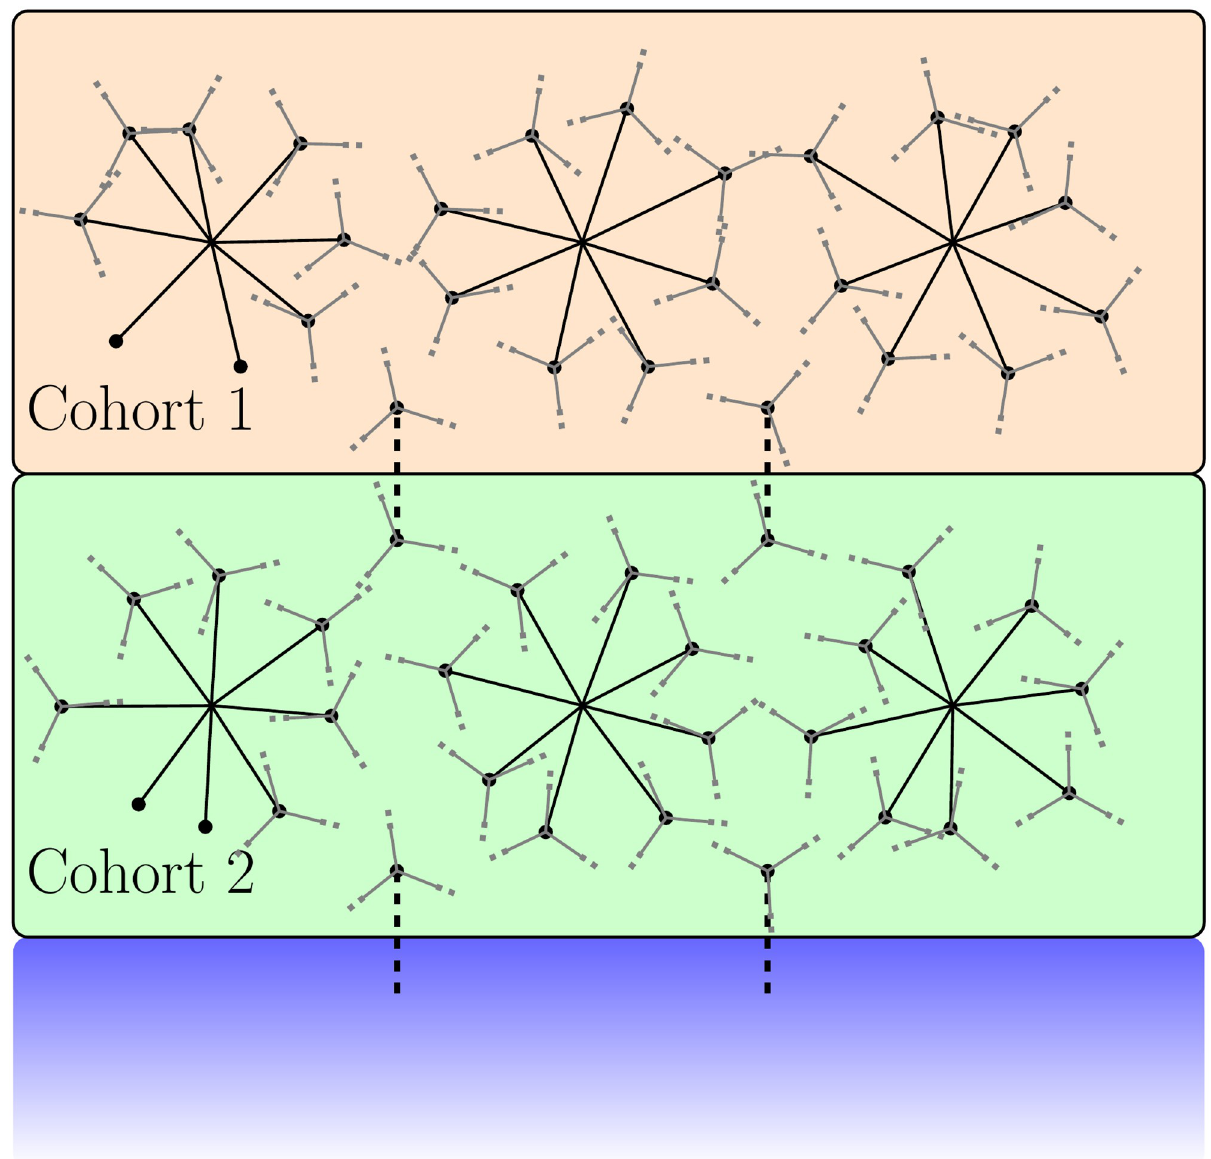
Fig 1. Schematic for the population structure of the model. Within each cohort, each agent is connected to a fixed number of randomly chosen agents. Successive cohorts are connected through relatively few spanning connections between agents in the two cohorts. The inter-cohort connections are shown dashed, representing a weak connection value compared to the intra-cohort connections. There are no connections between agents in non- adjacent cohorts. The blue box represents further cohorts which are modeled the same way as the first two. Specific values and details of the structure are given in Table 1 and in the text of the Model